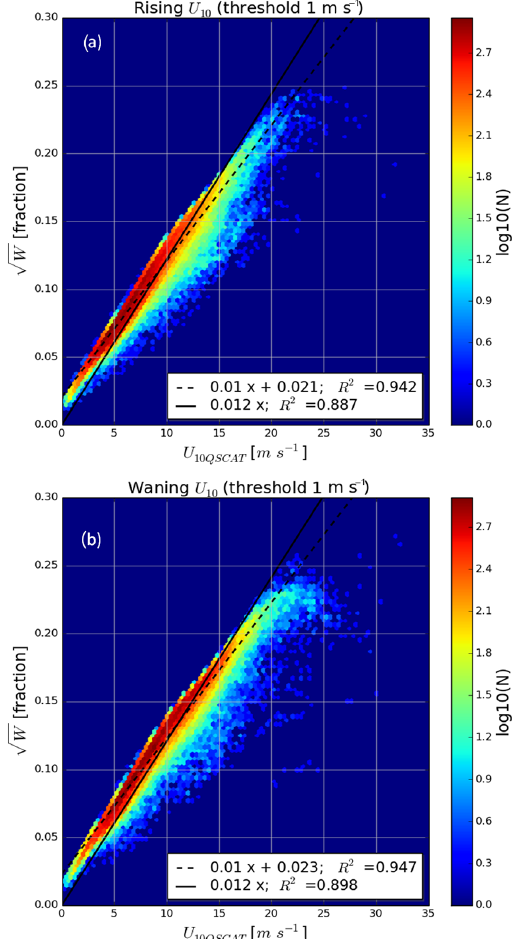
Figure 9. Global W 1 / 2 for data at 37GHz as a function of rising (a) and waning (b) U 10 from QuikSCAT for March 2006. The dashed line indicates the best linear fit through the data, whereas the solid line indicates a linear fit forced through